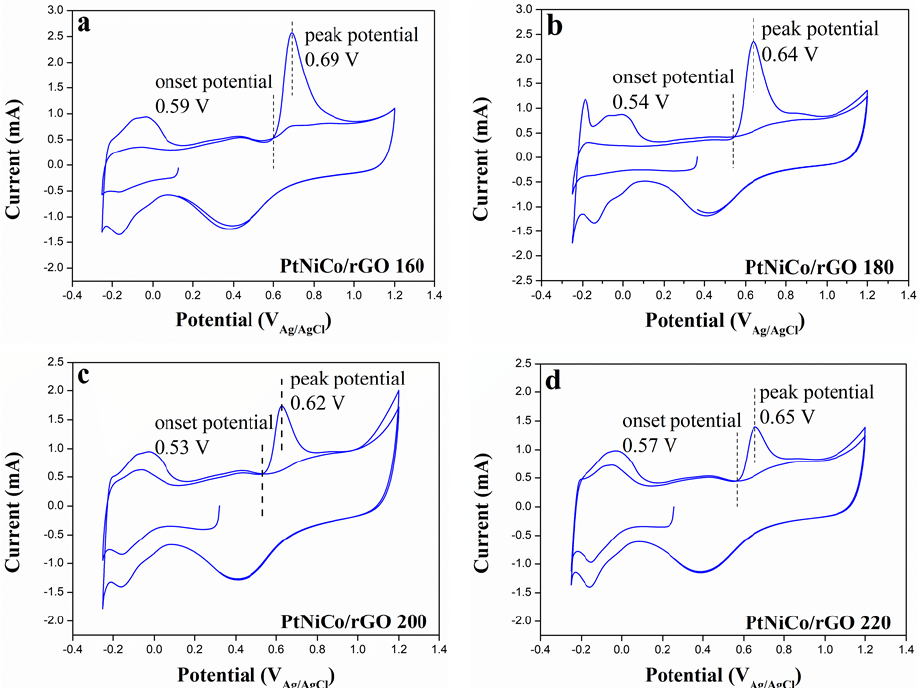
Figure 10. CO stripping curves of ( a ) PtNiCo/rGO 160, ( b ) PtNiCo/rGO 180, ( c ) PtNiCo/rGO 200, and ( d ) PtNiCo/rGO 220 in CO − purged 0.5 M H 2 SO 4 solution at scan rate of 50 mV/s. Table 1. ECSA and current density of methanol oxidation of various electrocatalysts in previous works. Electrocatalyst ECSA (m 2 /g)